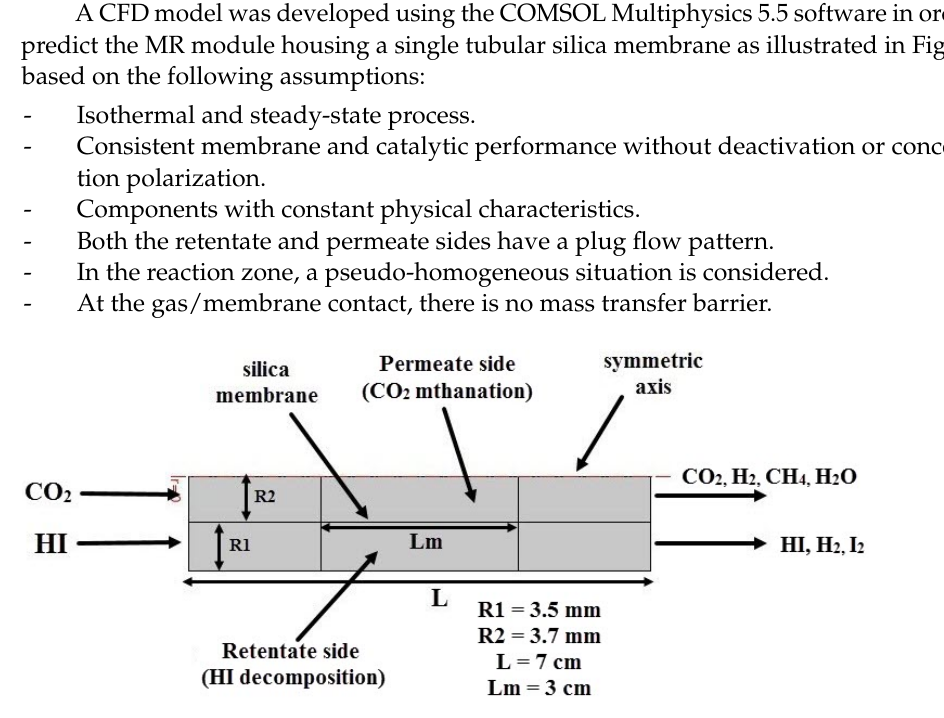
Figure 1. The simplified MR module scheme as a 2D-axisymmetric geometry. According to Figure 1, the “Feed” represents the inlet stream flowing into the silica MR, “Retentate” is the non-permeating outlet stream, and “Permeate” is the stream permeated through the membrane. A 2D axisymmetric model was created using the silica MR- modified